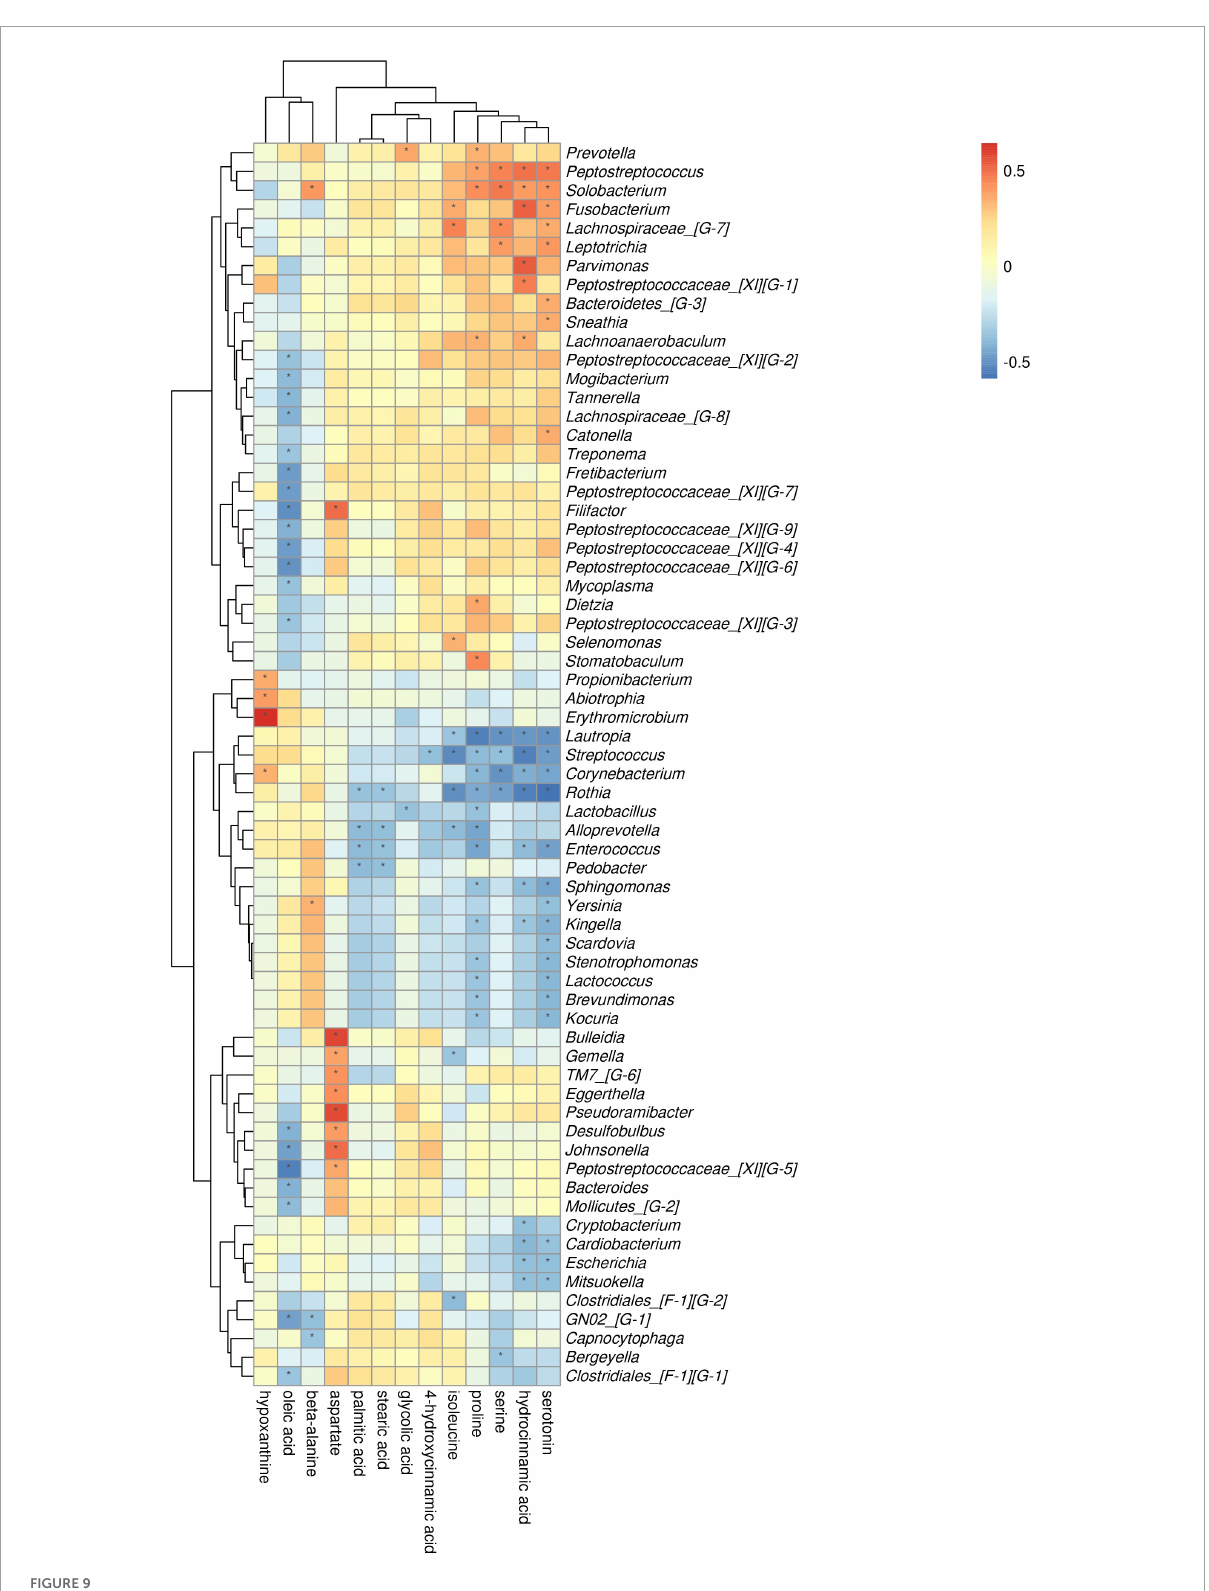
Frontiers in Microbiology